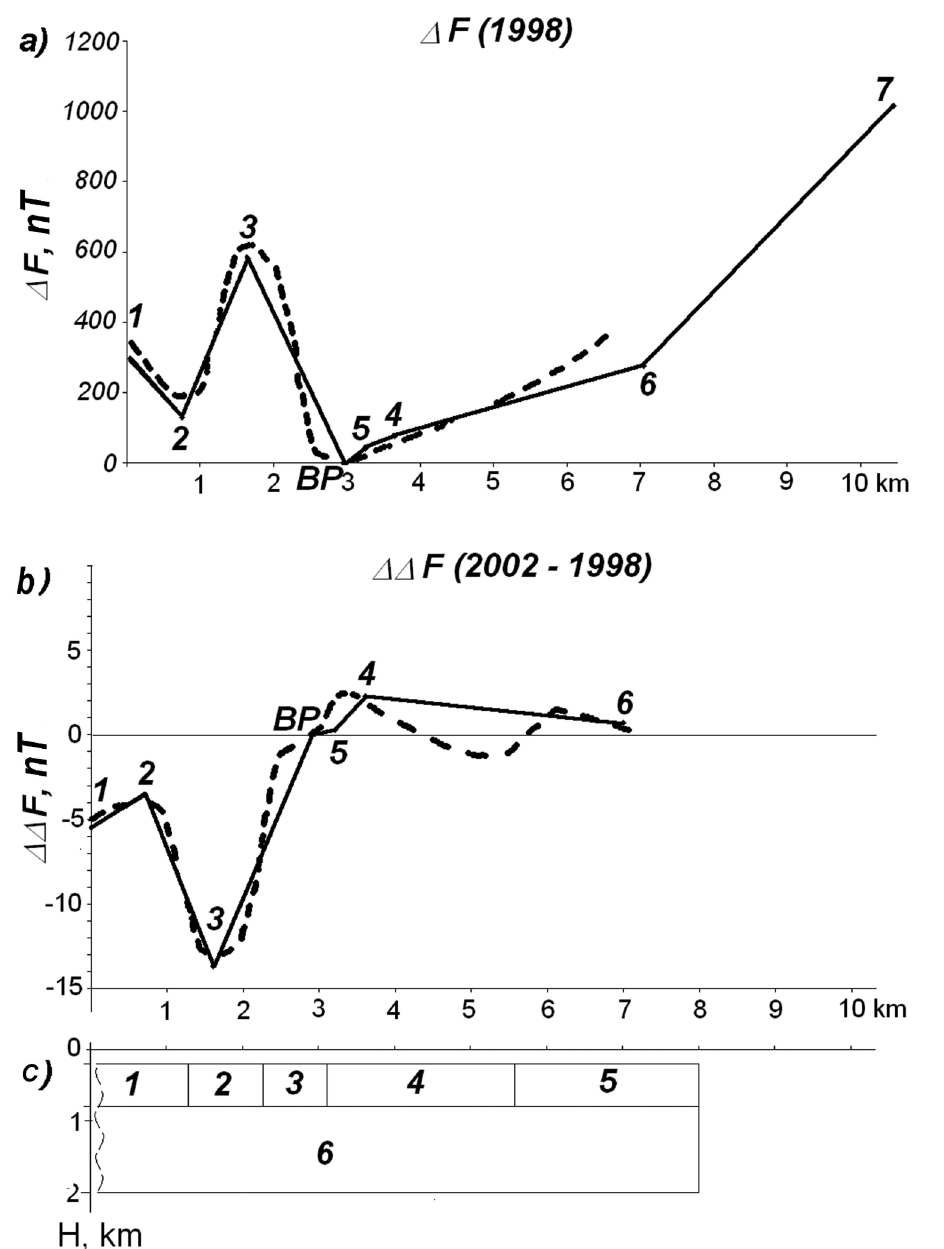
Fig. 4. The results of anomalous magnetic field ( ∆ F) and its temporal variations ( ∆∆ F) interpretation in the profile I – I (Barchany-Rasmussen) a) observed and calculated (dashed) curves of ∆ F, b) observed and calculated (dashed) curves of ∆∆ F along the profile I – I, c) a model of anomalies